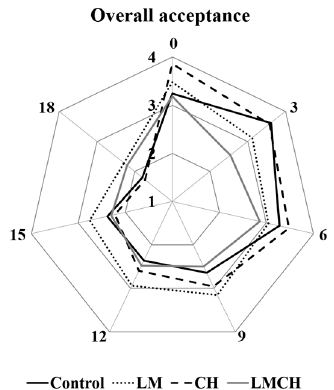
Figure 5. Overall sensory acceptance of fresh-cut cantaloupe with and without an edible coating (control) during 18 days of storage at 4 °C. Coatings 2019 , 9 , x FOR PEER REVIEW